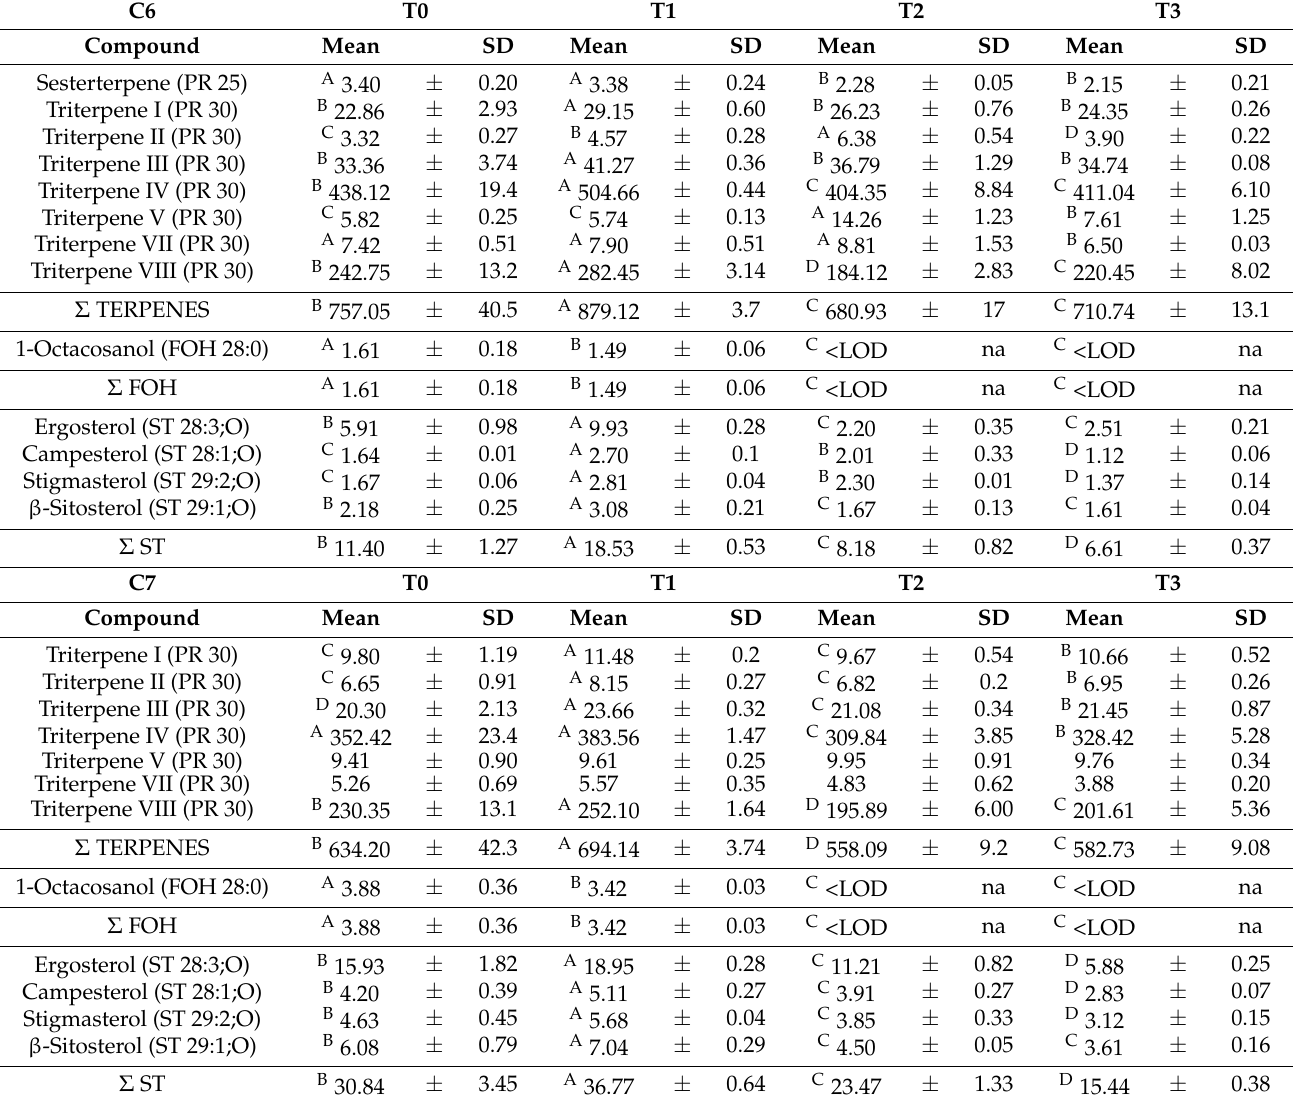
Table 3. Profile (g/kg) in terpenes, fatty alcohols, and phytosterols in distilled samples (C6 and C7) at the different assay times.